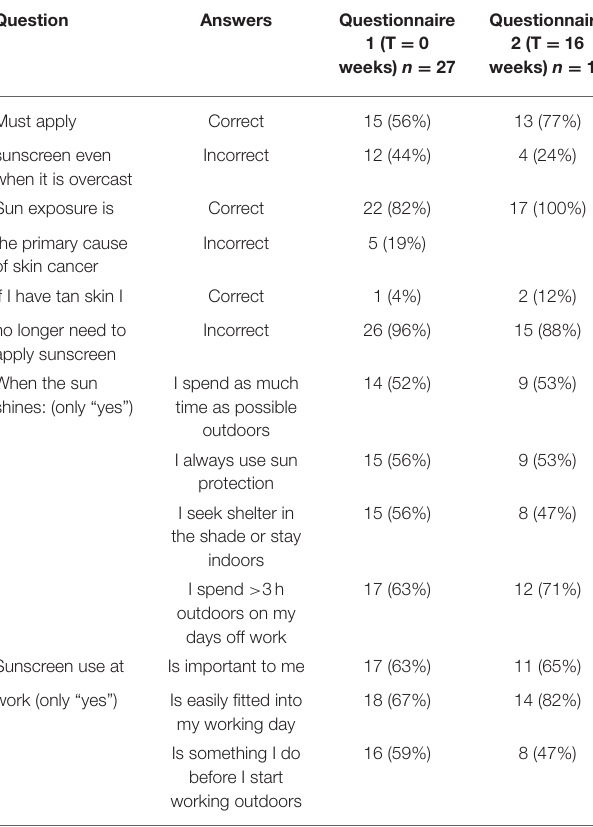
TABLE 2 | Sunscreen use